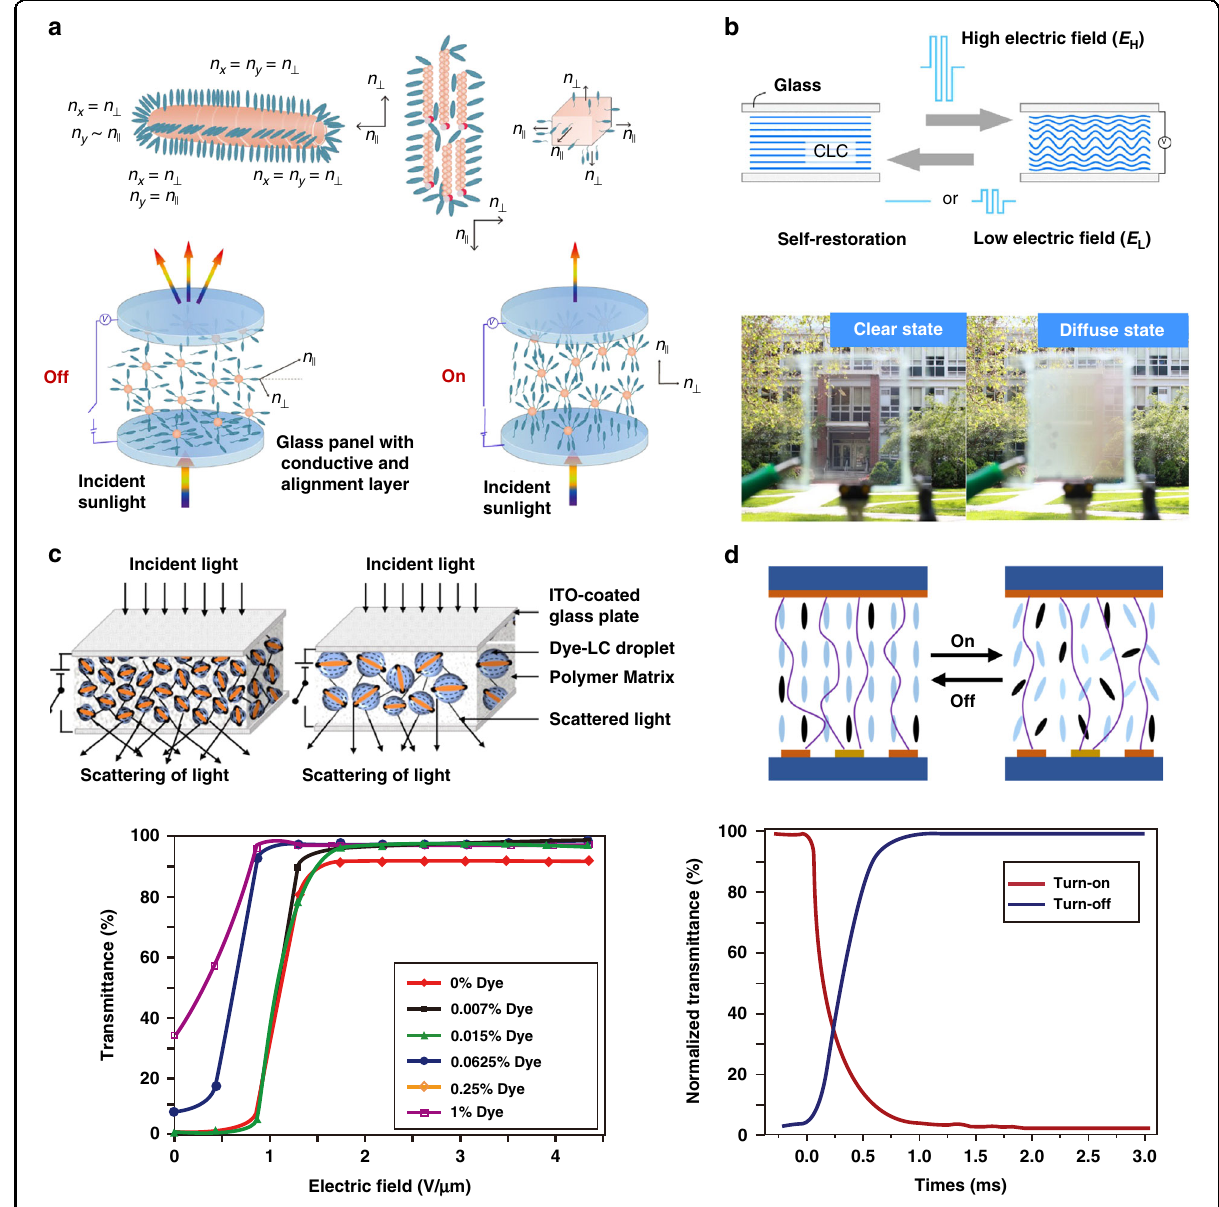
Fig. 13 Light protection strategies for windshields. a Light protection device based on doping LCs with low concentrations of nanoporous microparticles. The images above are three types of nanoporous microparticles. The picture below is a schematic diagram of nanoporous particles inducing molecular orientation of liquid crystals. b Light protection device based on CLC. Reproduced with permission from ref. 166 . Copyright 2018, Optica Publishing Group. The effect diagram of the device is shown above, and the schematic diagram is shown below. c The plot of transmittance vs. electric fi eld for PDLC with different dye concentrations and the scattering effect of PDLC thin fi lms for LC droplets with different diameters. Reproduced with permission from ref. 167 . Copyright 2022, Elsevier. d Graph of transmittance vs. time, electrode design of dye-doped PSLC,